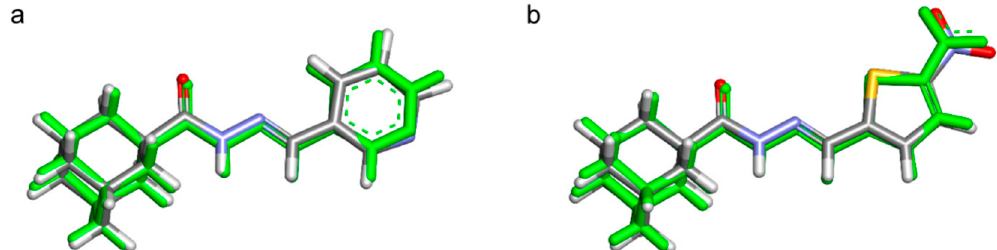
Figure 7. Density functional theory (DFT)-optimized geometries of compounds 1 ( a ) and 2 ( b ) at the B3LYP/6-31+G(d,p) level of theory. The corresponding crystal structures are shown superimposed in green. Atom color code: C (grey), H (white), O (red), N (blue), S (yellow).